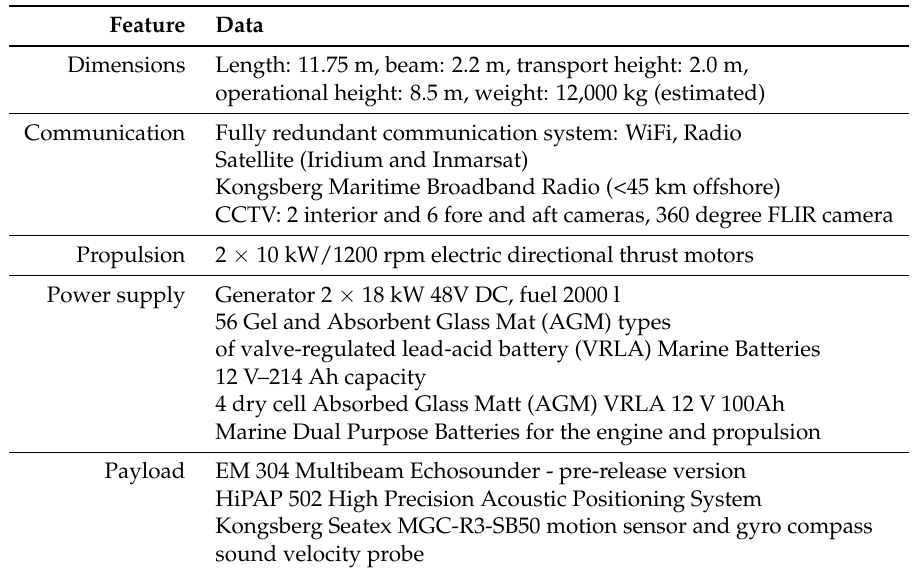
Table 2. Specifications of USV SEA-KIT ‘Maxlimer’, used for the data collection, transportation, launch and recovery, communication, and positioning of the AUV during the final survey in Kalamata, Greece.